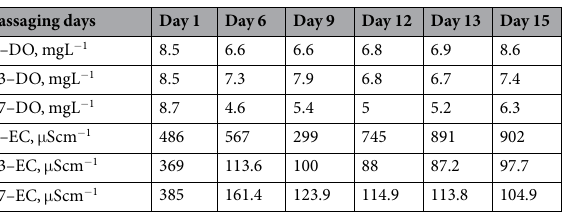
Table 4. Operational parameters of serially passaged control bioreactor samples and electro-bioreactors samples E3 and